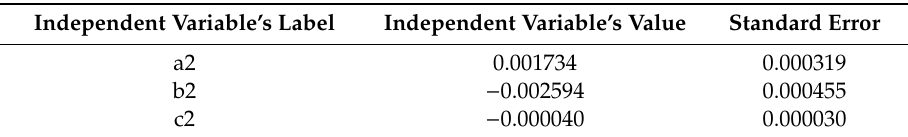
Figure 6. Normality diagram of residuals ( a ) and values observed against predicted ( b ).